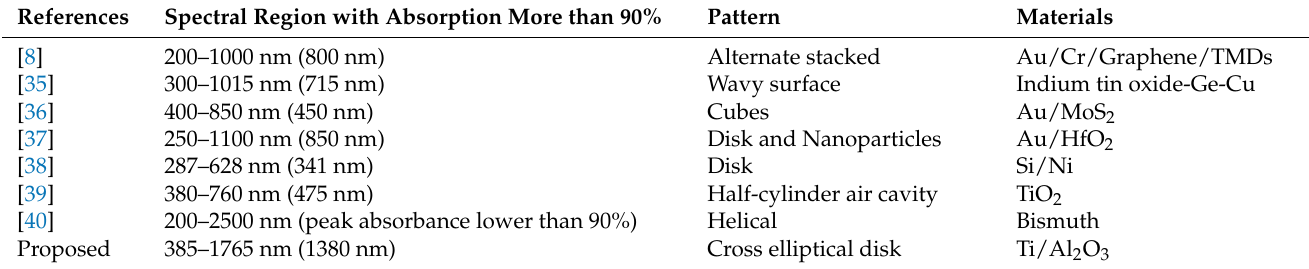
Table 1. Comparison of some recent solar energy